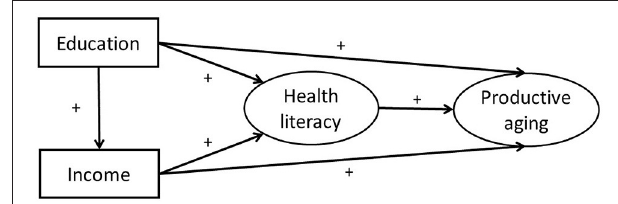
FIGURE 1 | The theoretical model and